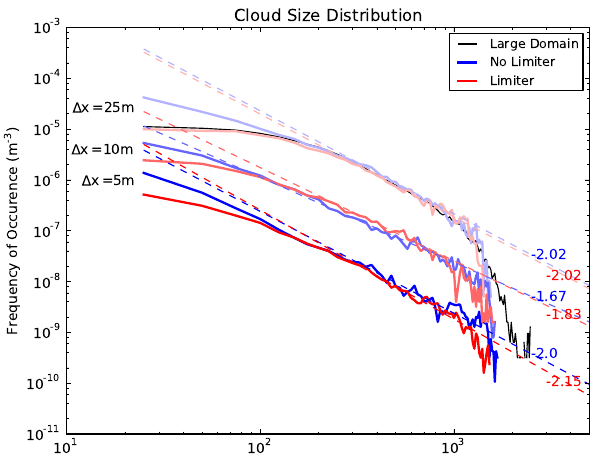
Fig. 14. Cloud size distribution as a function of resolution and the scalar advection scheme for hours 3–8 of RICO. Red colors: MUS- CLE flux limiter scheme. Blue colors: no limiter applied. For visi- bility reasons, The histogram for the 10m resolution has been mul- tiplied by a factor 10, and the 25m resolution with a factor 100. The benchmark run with large domain is shown as the thin black solid line. Dashed lines denote the best fit power law between 400 and 1000m; the numbers are the respective exponents of these power